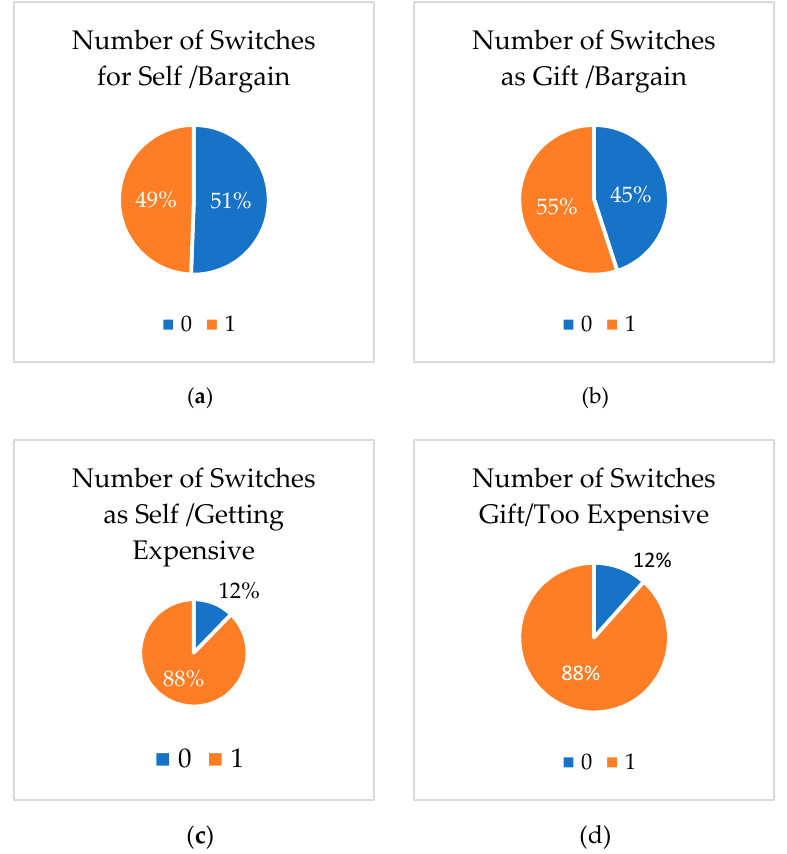
Figure 1. Number of inconsistent decisions of Switchers and Non-Switchers by the treatment group: ( a ) Self Purchase at Bargain price; ( b ) Self Purchase at Getting Expensive price; ( c ) Gift Purchase at Bargain price; ( d ) Gift Purchase at Getting Expensive price.